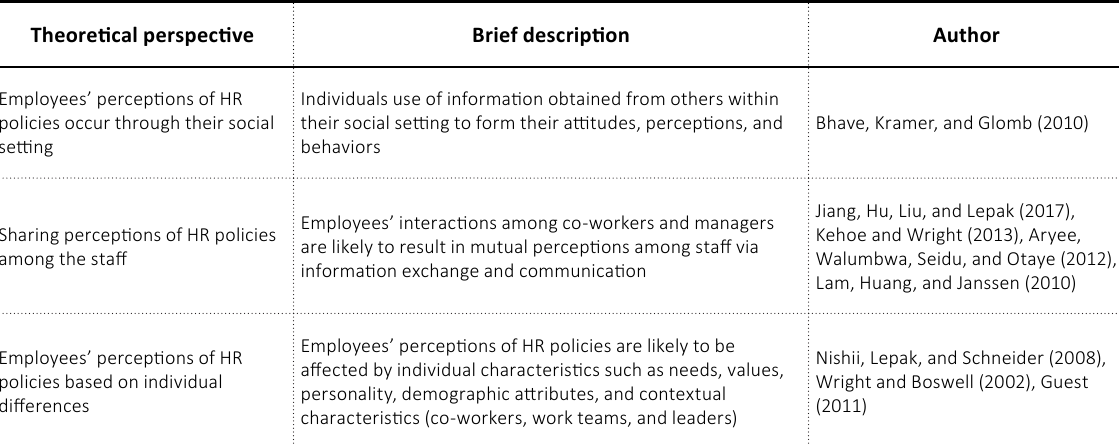
Source: Developed by the